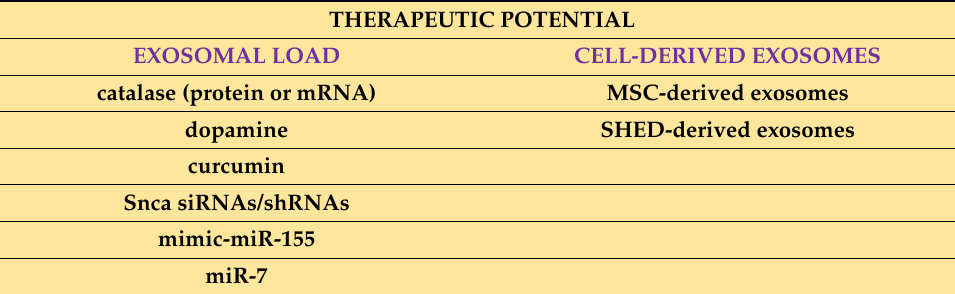
Table 2. Therapeutic potential of exosomes. A list of the suggested protein and RNA exosomal load of specific cell-derived exosomes used as therapeutic means against alpha-Synucleinopathies (mainly reported in PD). MSC: mesenchymal stem cells; SHED: human exfoliated deciduous